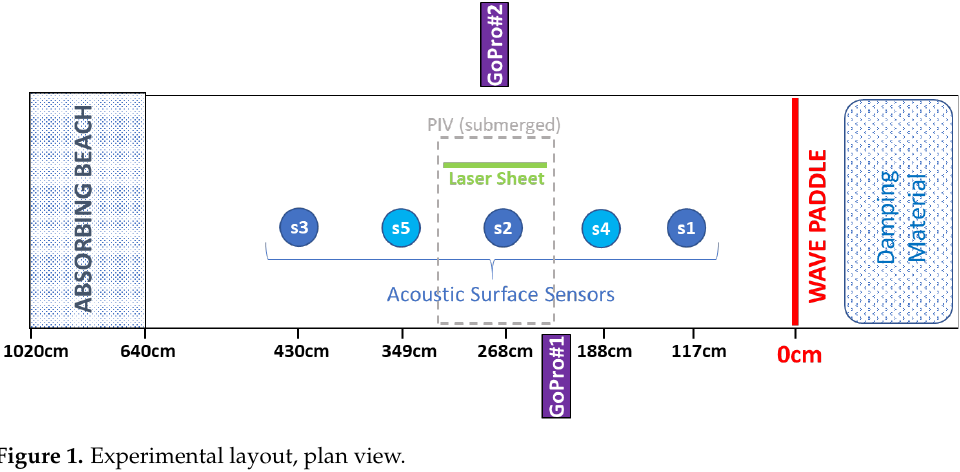
Figure 1. Experimental layout, plan view.